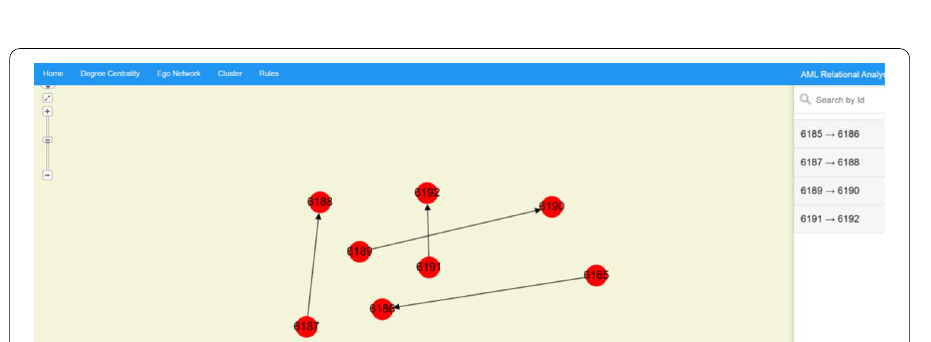
Fig. 13 Rule 5: Mother–child